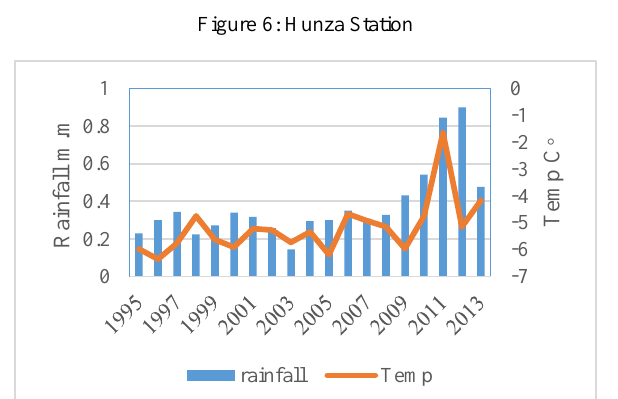
Figure 7: Khunjerab